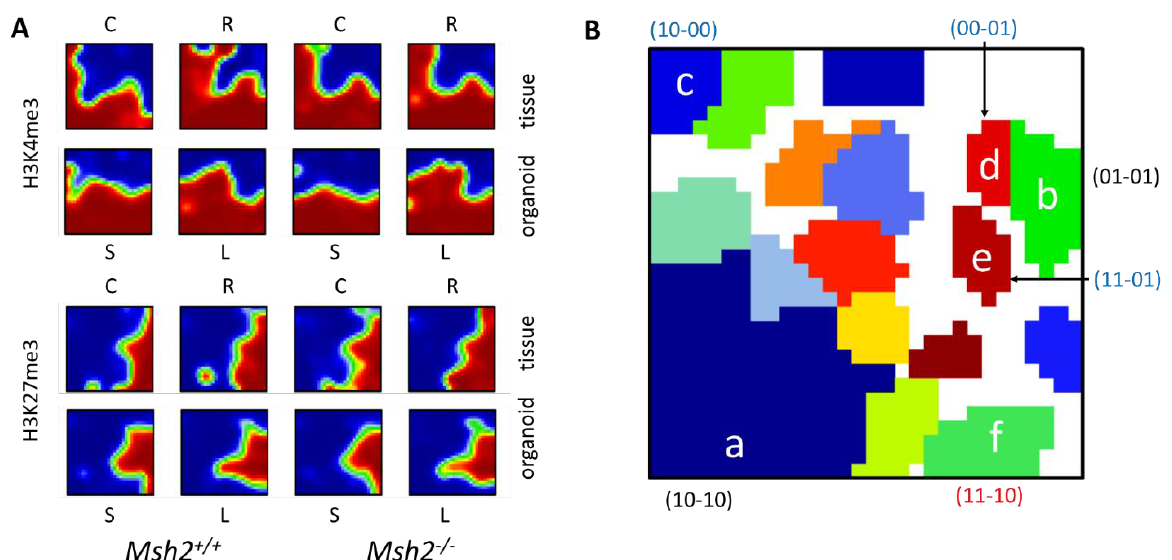
Figure 2. SOM analysis of histone modification states. The analysis integrates the organoid ChIP-seq data presented in this study and published ChIP-seq data on intestinal tissues [13]. ( A ) SOM portraits of all samples (C = control, R = radiated, S = short-term and L = long-term culture). ( B ) Gene clusters with specific regulations. Small letters (a–f) indicate the correlation clusters discussed in the text. The modification states of the cluster-associated genes in the tissue and organoids are indicated in parentheses.